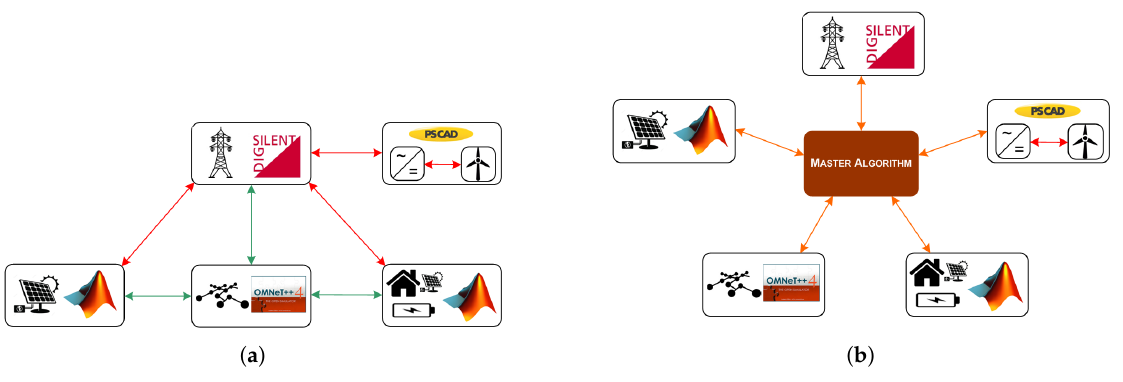
Figure 7. ( a ) Ad-hoc Co-Simulation; ( b ) Co-Simulation with an